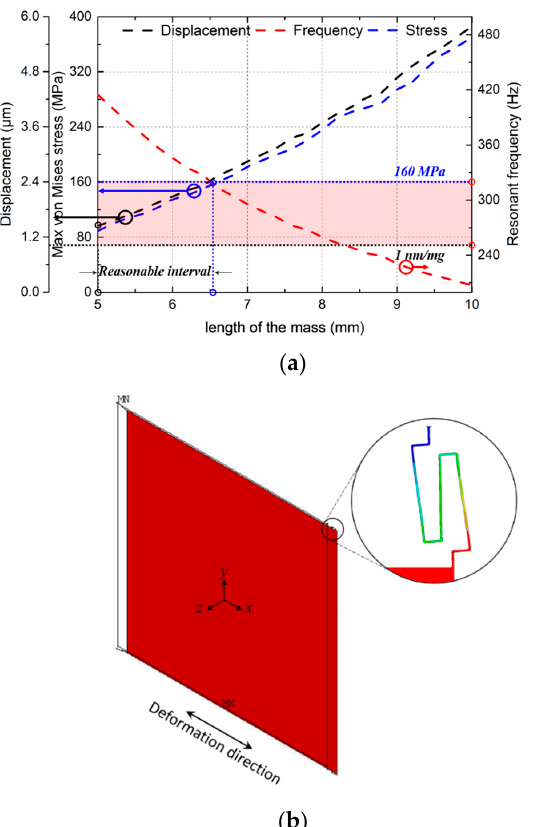
Figure 12. ( a ) Relationship between displacement along the x -axis, the maximum von Mises stress, the resonant frequency, and the length of the bulky plate when the structure was subjected to one g acceleration along the x -axis, where dotted lines mark the reasonable interval of the length according to the target performance and tensile strength of the material; ( b ) second modal deformation of the structure. Inset: deformation of a suspension beam in this